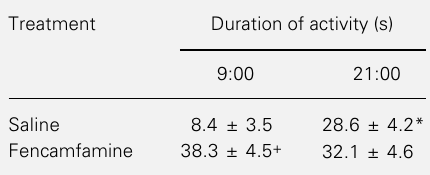
Table 1 - Effects of fencamfamine on the behavior- al response of rats. Animals (N = 8 rats per group) received saline or FCF (3.5 mg/kg, ip , single dose) at 9:00 or 21:00 h. The duration of activity (s) was recorded for 2 h at 15-min intervals. Data are reported as mean – SEM. *P<0.01, saline vs saline; + P<0.01, FCF vs saline (Student t -test).